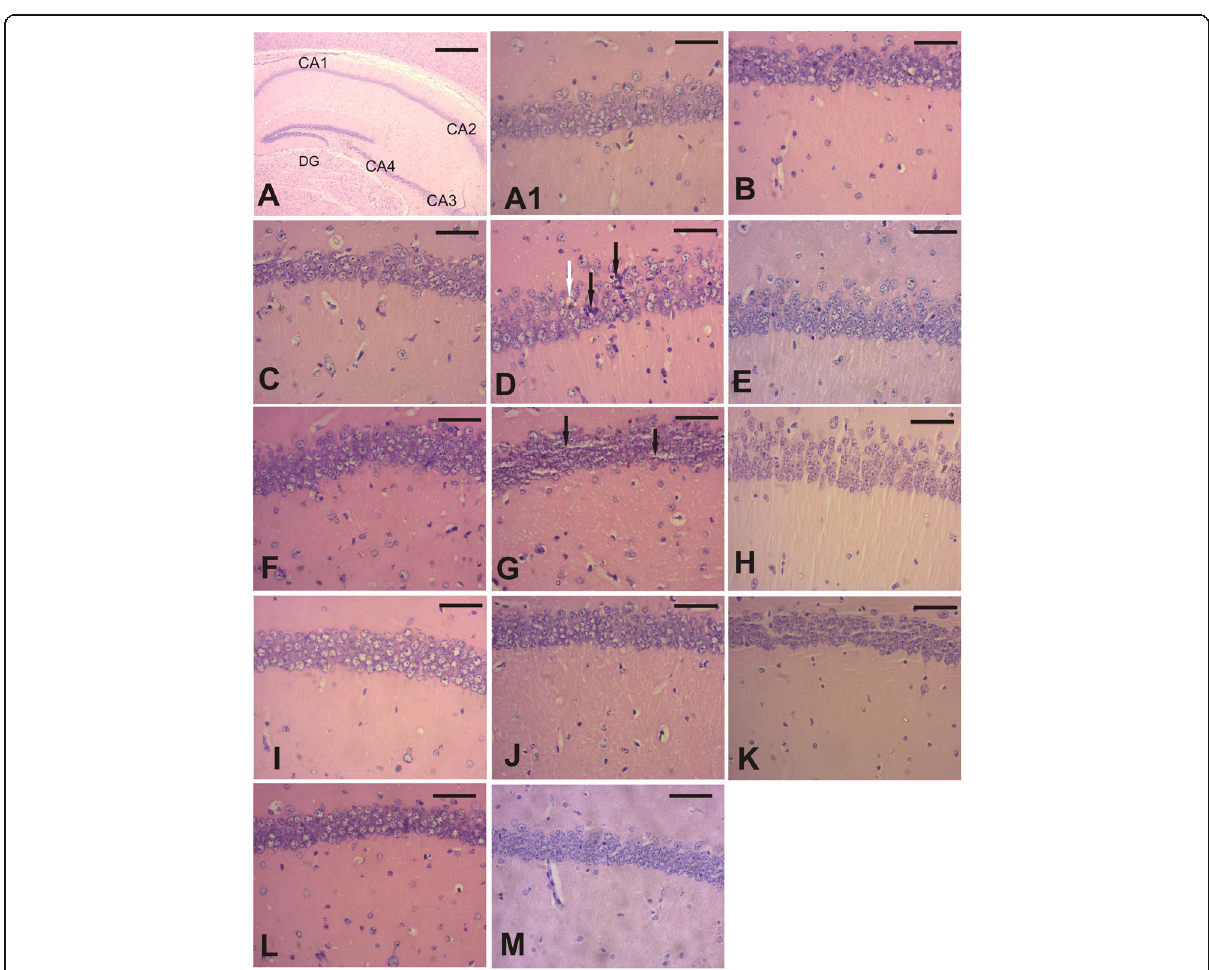
Fig. 4 Photomicrographs of stained sections of the hippocampus showing the anatomy ( a ) and the small pyramidal cells in the CA1 zone of the control group ( A1 ). Inflammation cells (white arrows) and cell vacuolation (black arrow) of the CA1 zone in the acrylamide-administrated group for 60 days ( d ) are shown compared to the control ( A1 ) and acrylamide administration for 30 and 45 days ( b , c ), respectively. Cell vacuolation of the CA1 cell zone in the chips feeding group (arrows, g ) is shown at 60 days compared to both 30 and 45 days ( d , f ) of the chips feeding group. The BV- ( h ) and BPF- ( i ) treated groups for 60 days are similar to the control group. The acrylamide-administrated groups treated either with BV ( j ) or with BPF ( k ) showed improvement as compared with the acrylamide-administrated group for 60 days. The chips feeding groups treated either with BV ( l ) or with BPF ( m ) showed improvement as compared with the chips feeding group for 60 days. H&E stain; scale bar, A is 50 μ m; A1 – M is 10 μ